Question: Provide a publication-style caption for this figure.
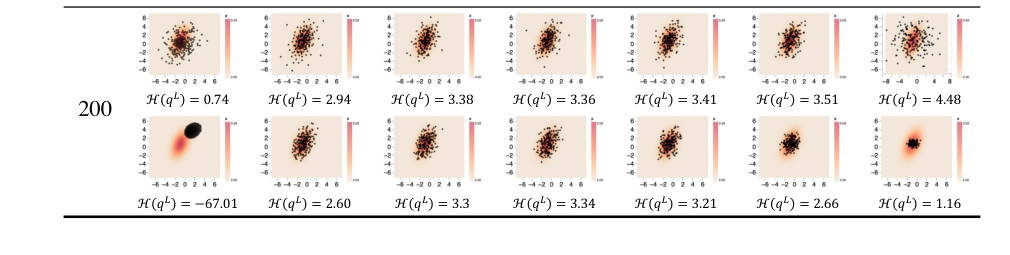
Answer: Visualization of the particles after L steps of SVGD for the different configurations of kernel variance σ and number of particles m in Figure 4b.